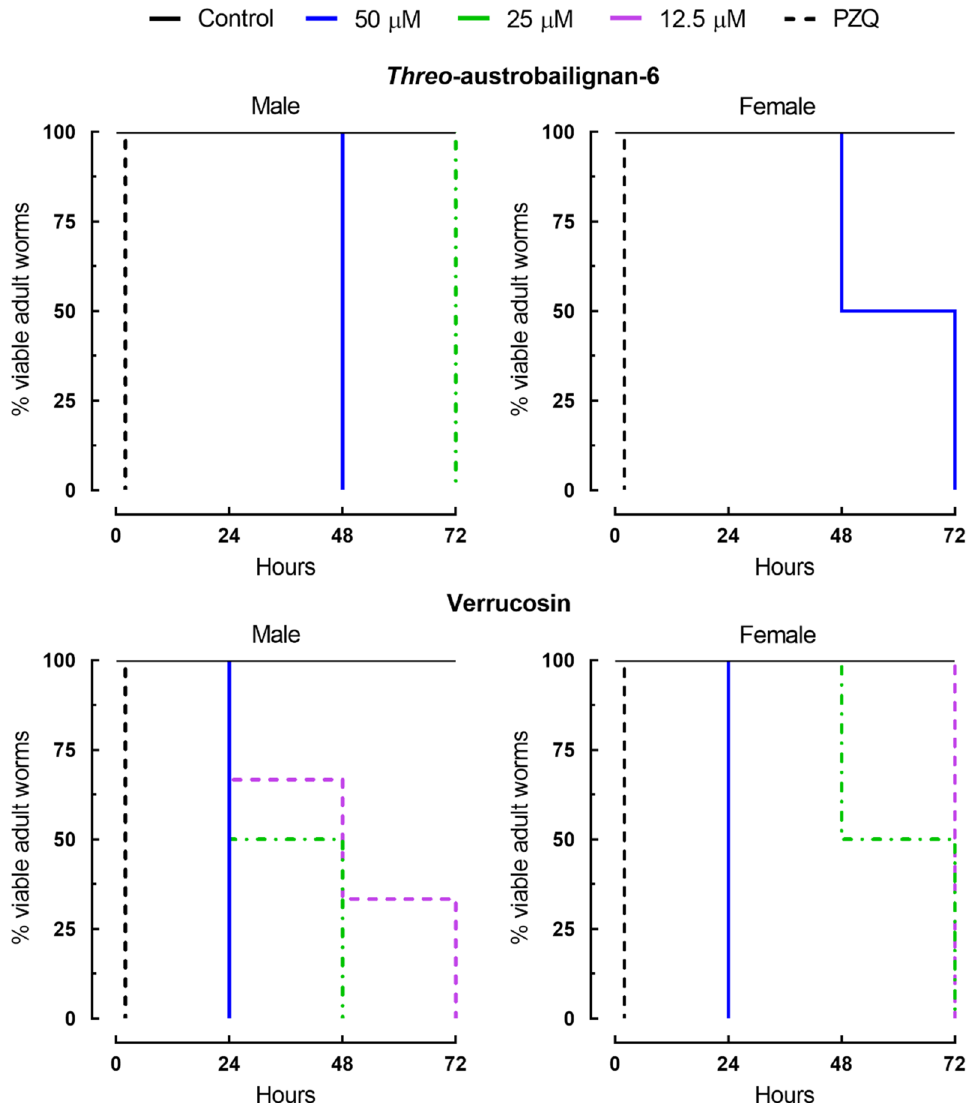
Figure 3. Viability of ex vivo adult S. mansoni worms following exposure to neolignans. Adult worm pairs were obtained from mice by perfusion 42 days after infection. Parasites were monitored for up to 72 h, and results are expressed as the percent mortality recorded by Kaplan–Meier survival curves. Mean values of viability were derived from a minimum of three experiments ( n = 3). Control: drug-free medium. PZQ: praziquantel at 2